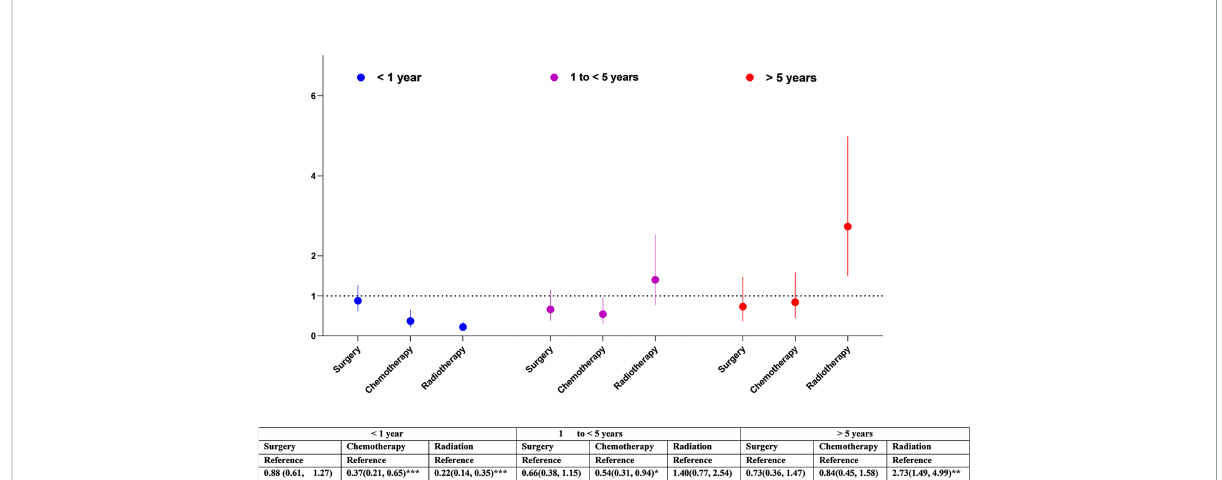
FIGURE 3 Association of cancer treatment with cerebrovascular mortality in glioma patients by different follow-up periods. The hazard ratios (HRs) were calculated using cox regression model and adjusted for sex, race/ethnicity, marital status and calendar years, tumour size, cancer treatments. The reference groups were those who did not receive the treatment: surgery, chemotherapy, or radiation. CI, Con fi dence intervals. Signi fi cance code: *** p<0.001, ** p<0.01, * p<0.05.